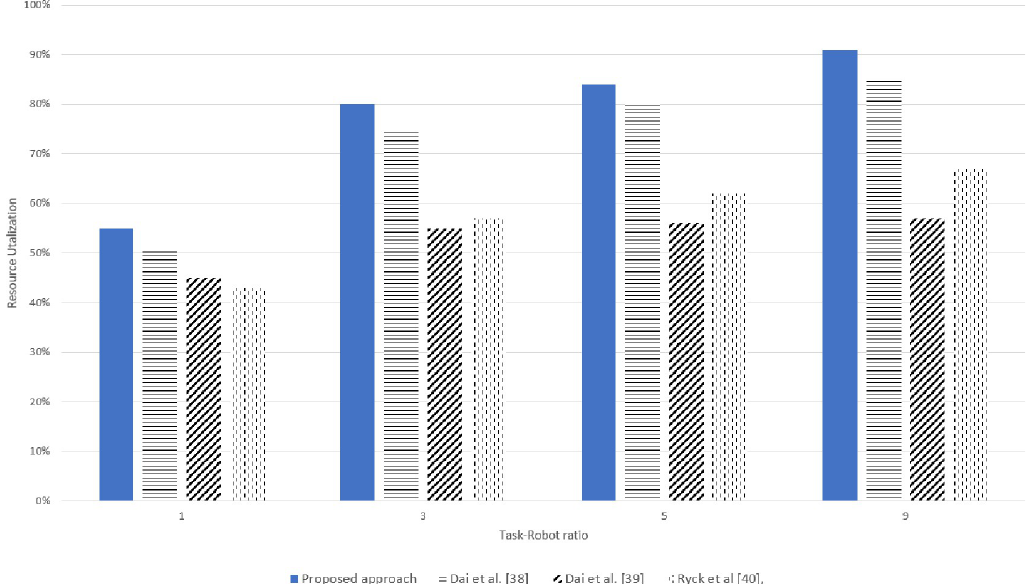
Fig 14. Real experimentation for resource utilization for various task-robot